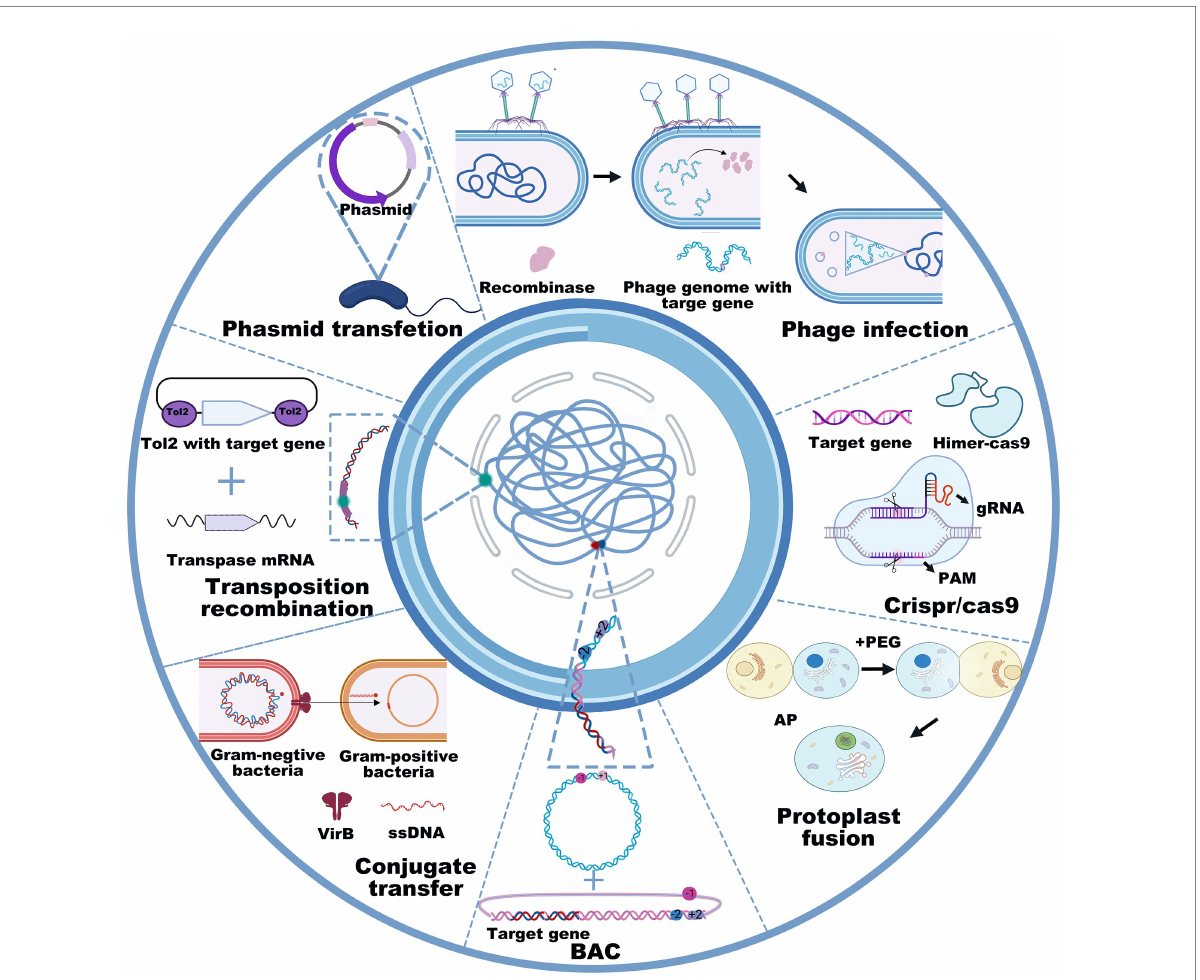
FIGURE 2 General used recombination technologies, including phage infection, phasmid transfection, transposition recombination, conjugate transfer, BAC, protoplast fusion, and CRISPR-Cas9 in counter-clockwise